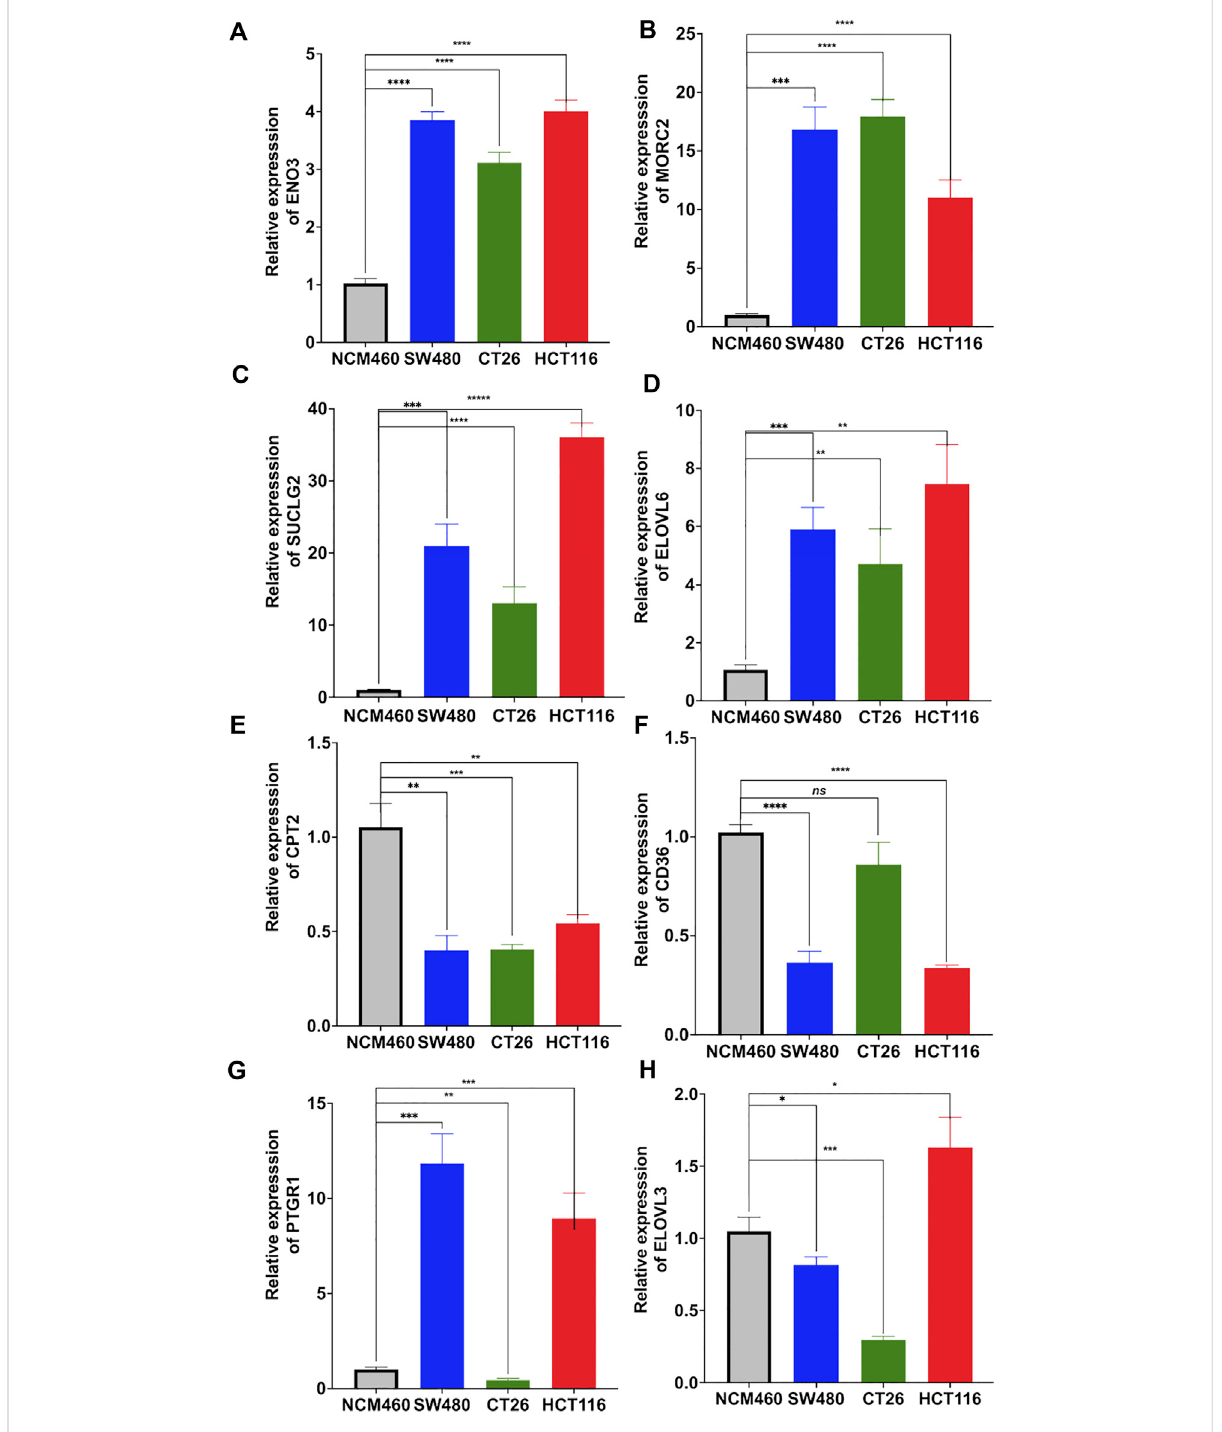
FIGURE 9 Relative mRNA expression of the risk signature genes. Real time quantitative PCR was utilized to compare the expression of ENO3 (A) , MORC2 (B) , SUCLG2 (C) , ELOVL6 (D) , CPT2 (E) , CD36 (F) , PTGR1 (G) and ELOVL3 (H) between human colon mucosal cell line (NCM460) and colon adenocarcinoma cell lines (SW480, CT26 and